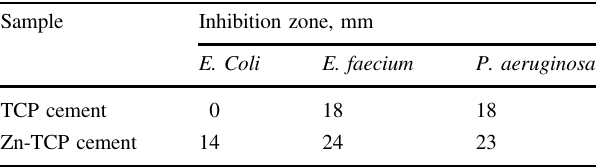
Table 2 Antibacterial activity of the cements against E. coli , E. faecium , and P. aeruginosa